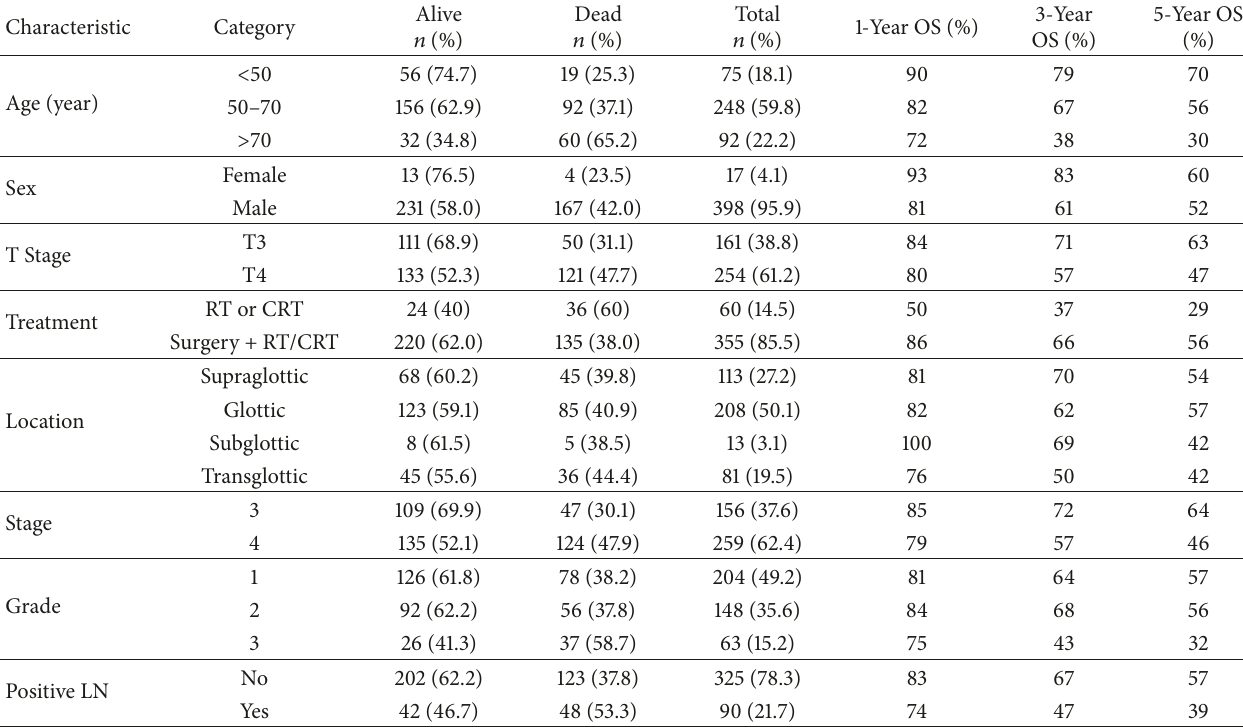
Table 1: Characteristics of study participants ( 𝑛 = 415 ) and 1-, 3-, and 5-year survival among patients diagnosed with laryngeal cancer, South of Iran, 2000–2015.